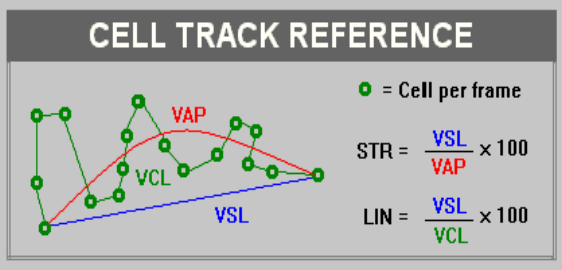
Figure 1: Sperm Tracks and